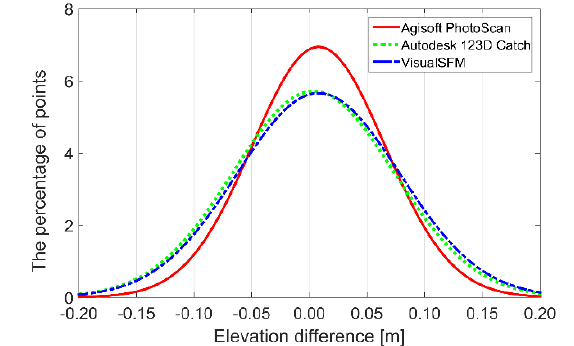
Figure 6. Normal distribution of elevation difference between each SfM result and DSM of the TLS